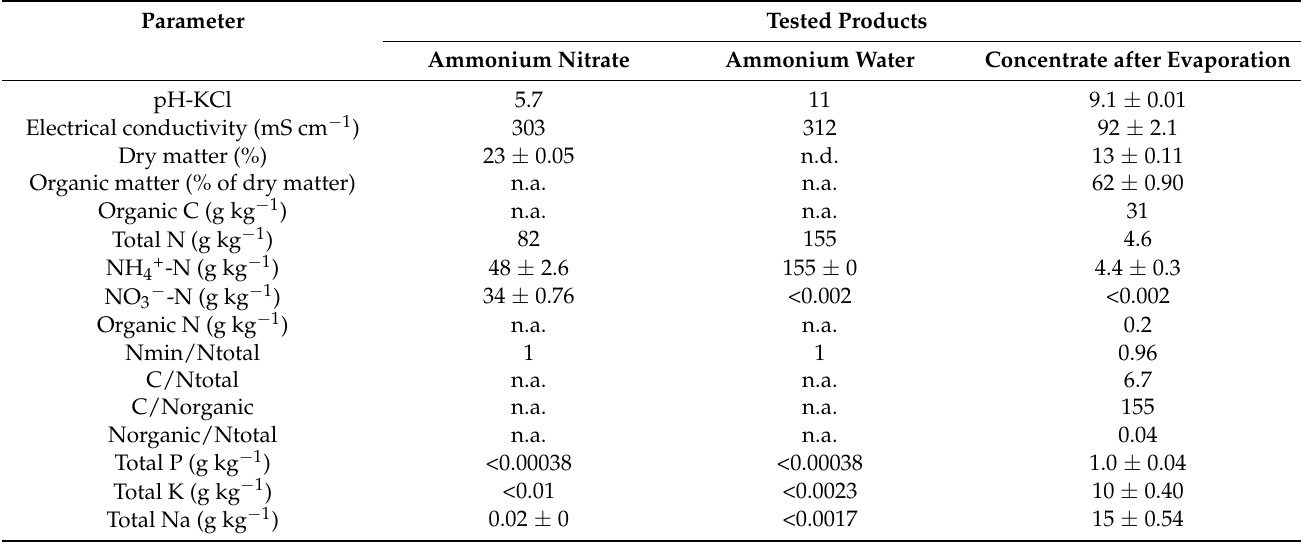
Table 3. The physicochemical characterization of tested products presented on a fresh weight basis. The pH and EC (of CaE), dry matter, organic matter, mineral N (NH 4+ -N and NO 3 − -N), and total P, K, and Na results presented as mean ± standard deviation (n = 2).